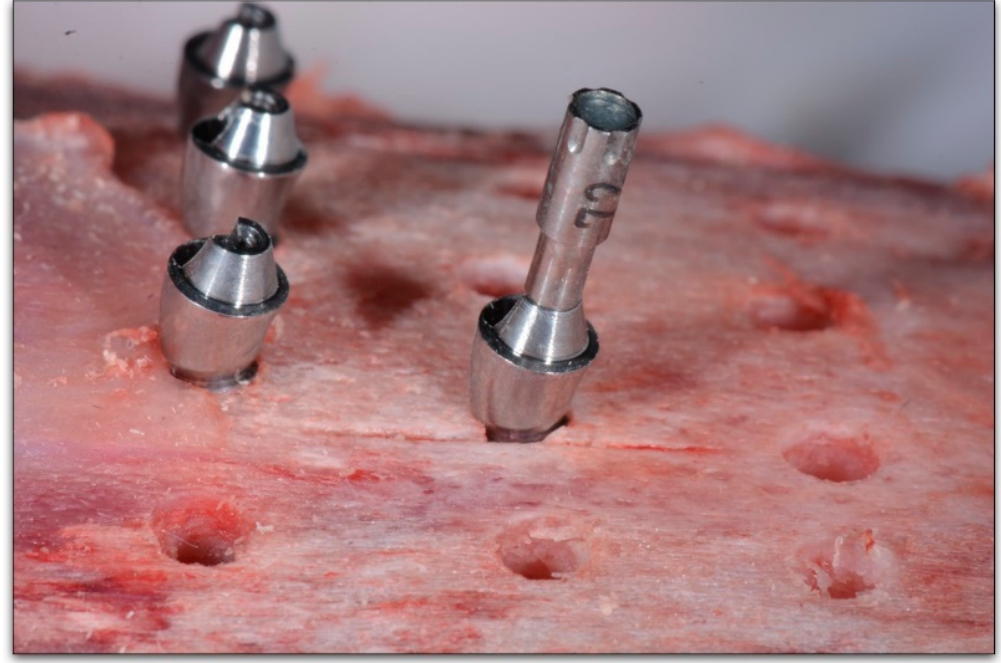
Figure 3. Resonance frequency analysis with Penguin RFA to Multipeg ® Reference 72 for the Permanent ® , 18° angled abutment with a 2 mm height for Vega ® with a 4 mm diameter).